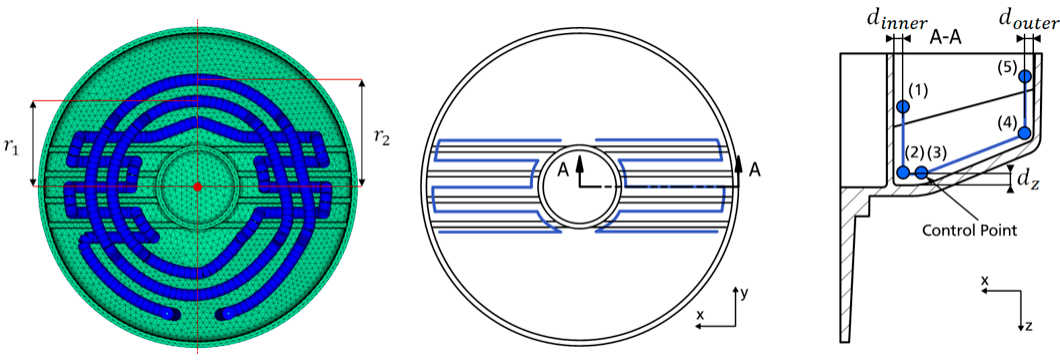
Figure 9. Initial close-contour cooling system in top view ( left ) and rib region parametrization ( middle to right ).